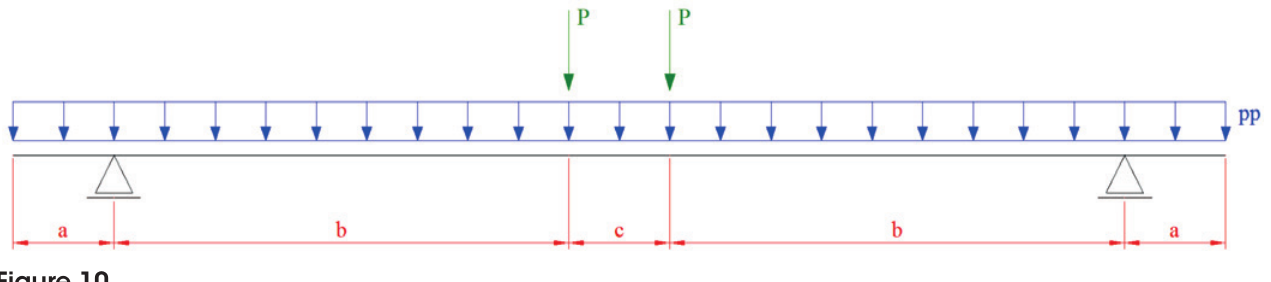
Static scheme of the tested lattice